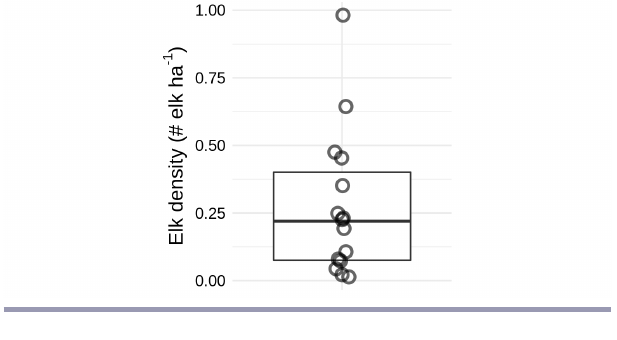
Fig. 2. Elk density on interviewee land. Elk density is derived from landowner reports of elk abundance on their land.